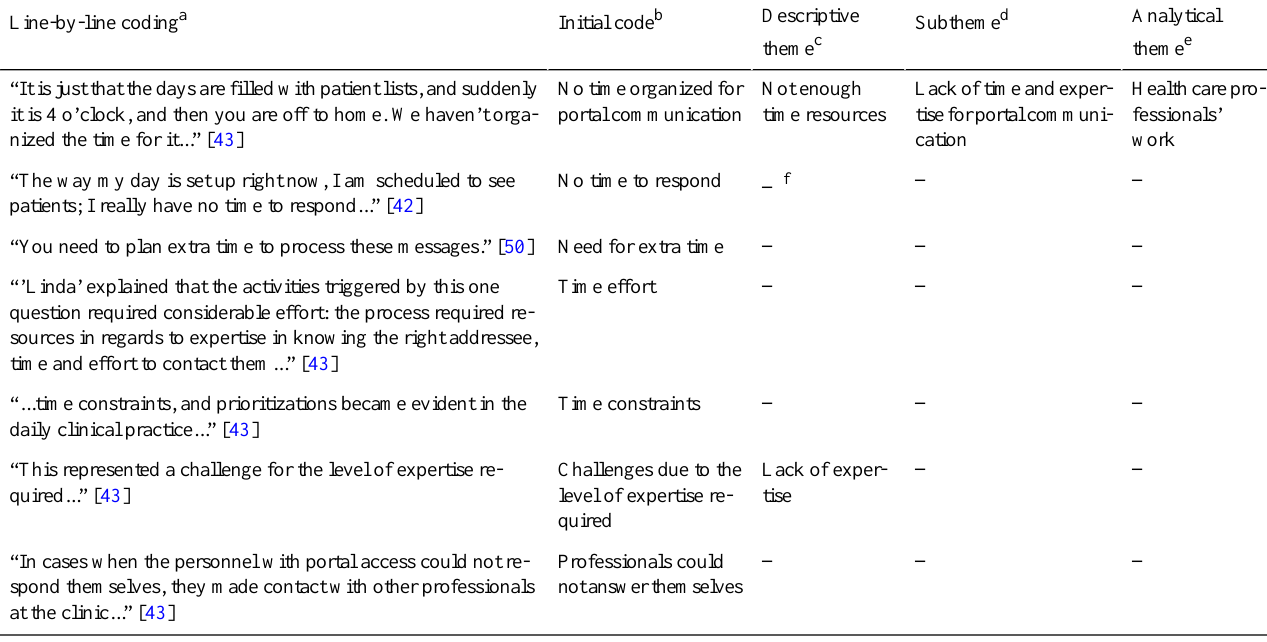
Table 4. An example of coding in thematic